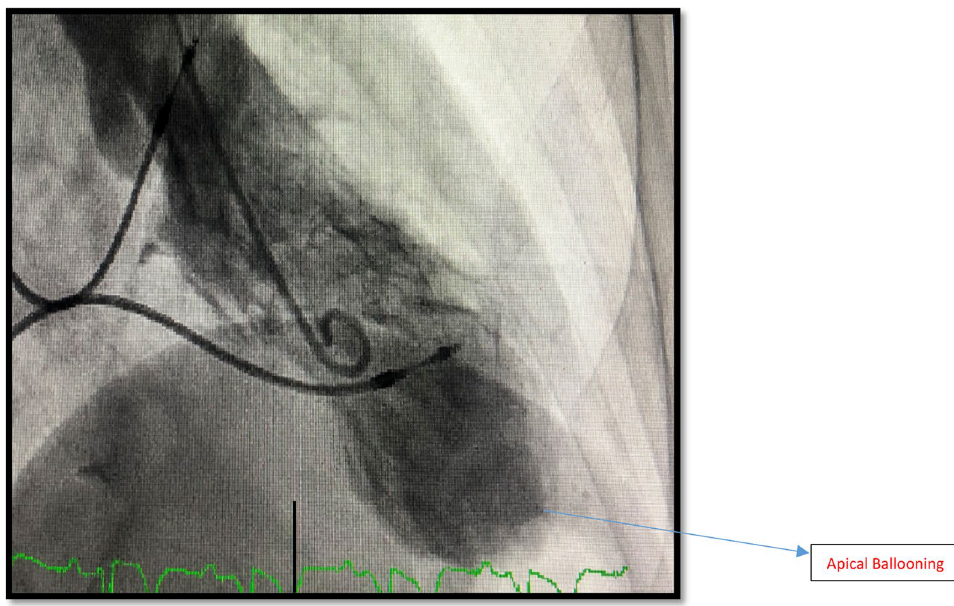
Fig. 5 LV gram showing Apical Ballooning—Case